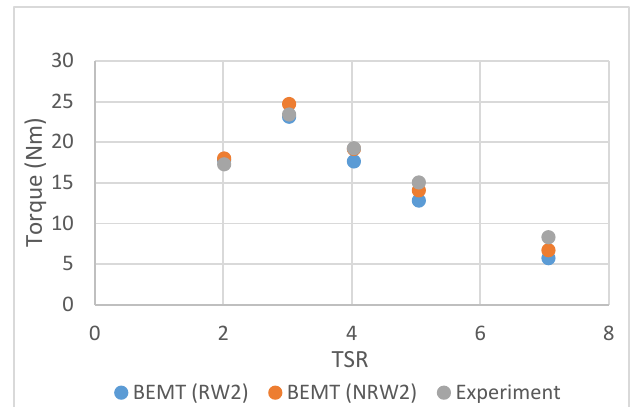
Figure 15. Torque comparisons between BEMT calculations and experimental data for the inflow profiles with and without a turbine when the turbine operates under wave-current interactions with a wave height of approximately 0.09m and an apparent wave period of 0.5s.